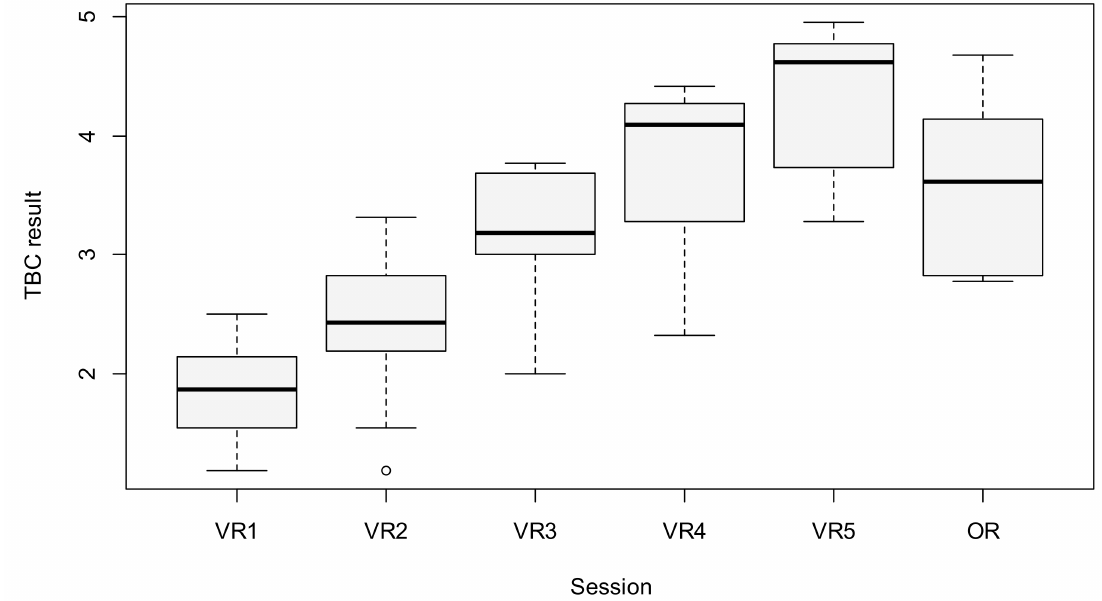
Figure 3. Boxplot of TBC results between sessions (the circle above VR2 represents an outlier